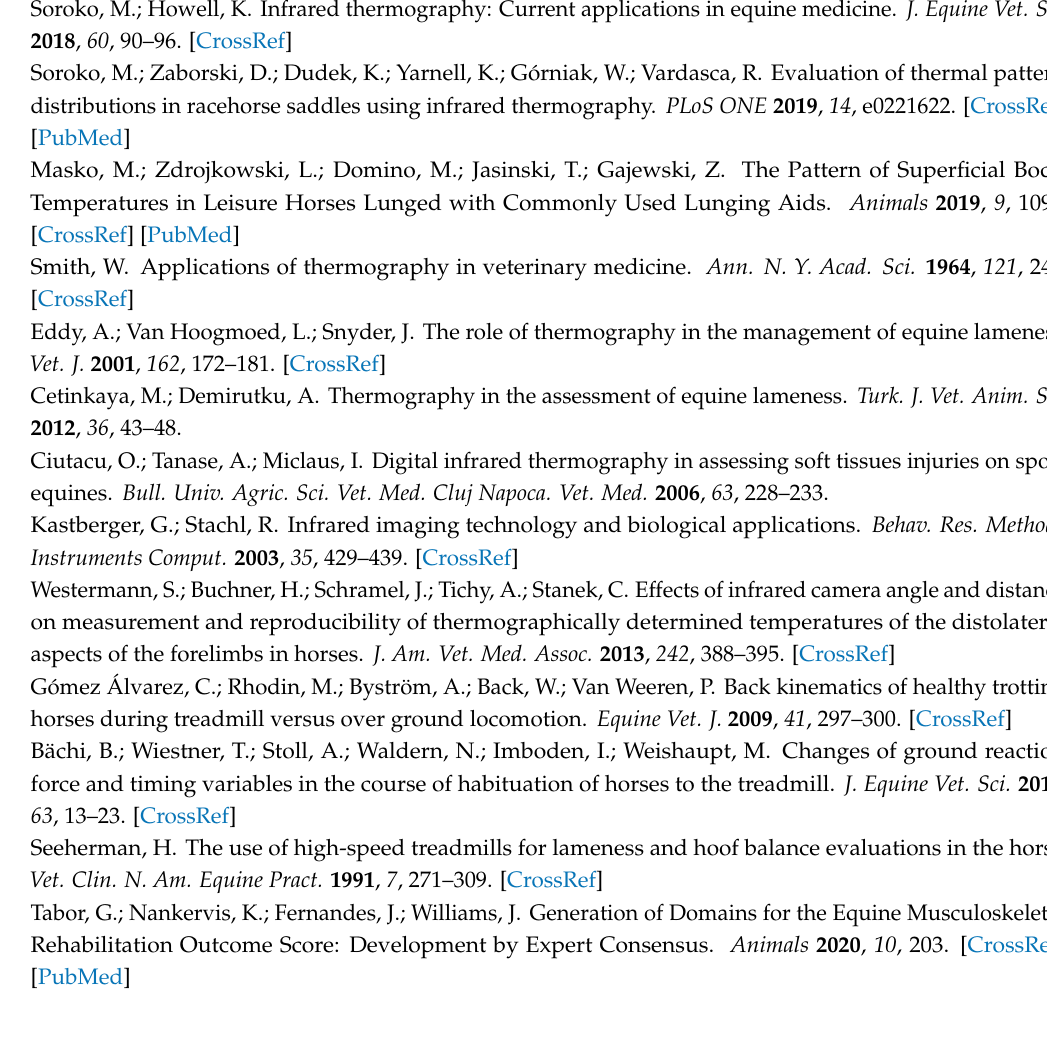
Figure A2. Thermal patterns, i.e., statistically significant ( p < 0.001) differences between the mean temperatures in GORs for the two donkeys identified as outliers (see Section 2.1): ( a ) donkey D.17 ; ( b ) donkey D.18 . Bold font indicates the statistical significance of the difference for the given pattern ( p <